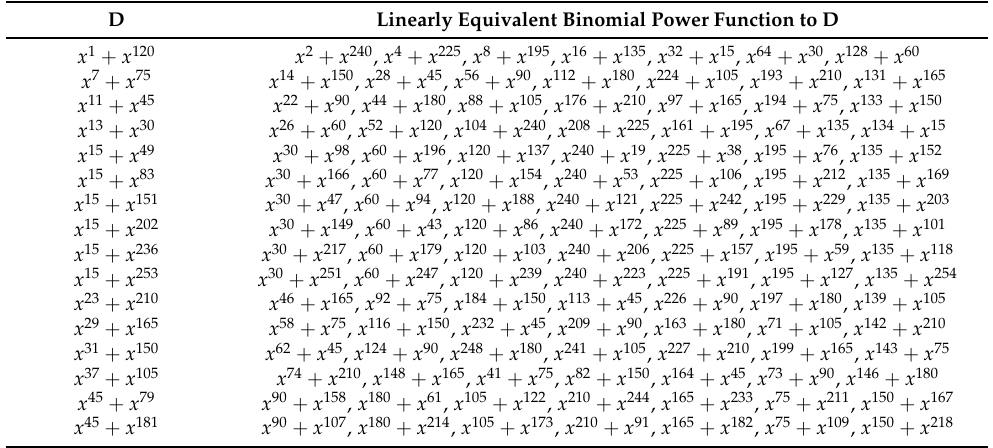
Table A3. Classification of Linearly Non-Equivalent Binomial Power Function with 85 to 1 Output.